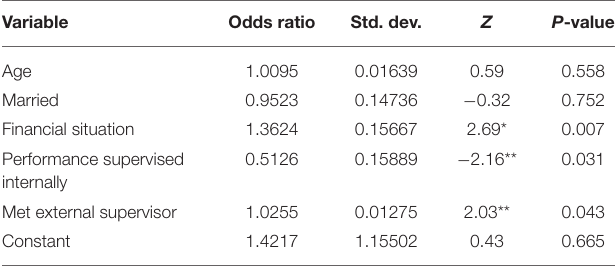
TABLE 5 | Results of the Binary Logistic Model. Dep. Var. Absenteeism. Variable Odds